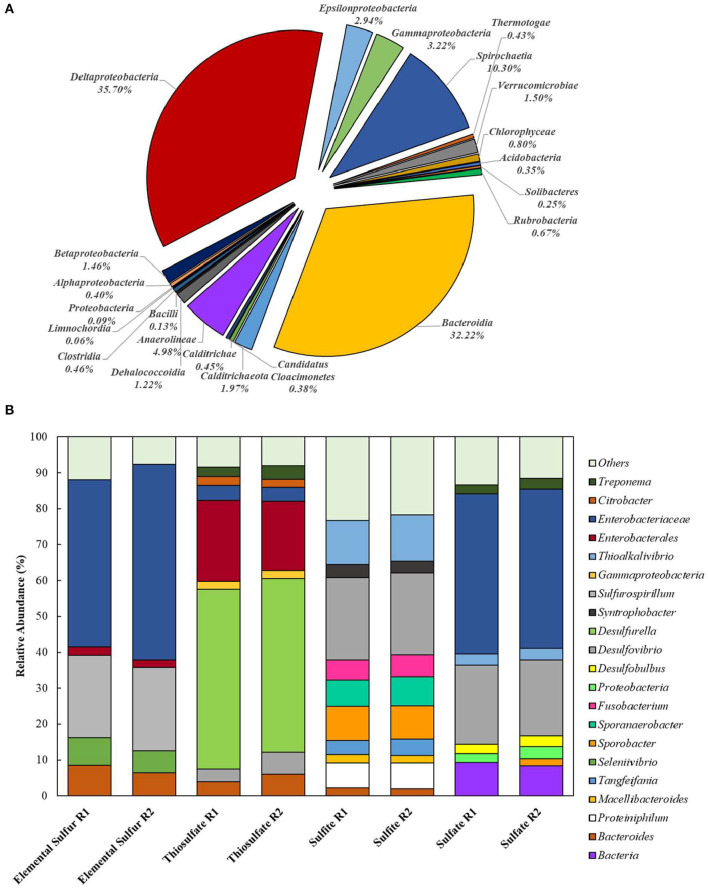
Bacterial diversity in the (A) inoculum (at the class level) and in the (B) 4th transfer enrichments on early stationary phase (at the genus level). Groups that could not be identified at the mentioned level were classified at the next highest possible resolution level. OTUs with less than 2% sequence reads were combined in the group “Others.” R1 – replicate 1; R2 – replicate 2.